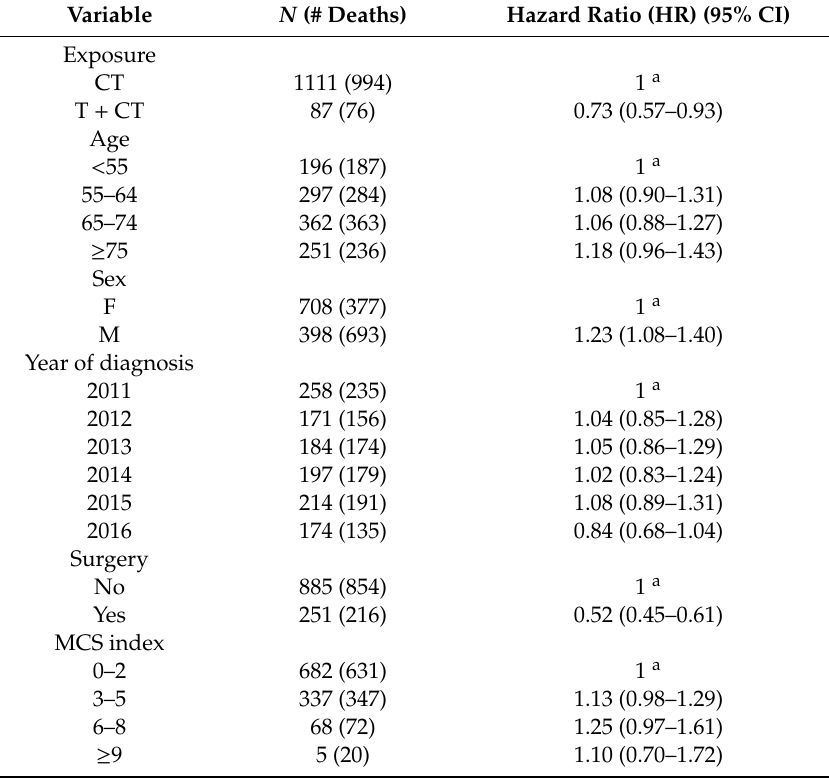
Table 2. Association between first-line treatment and overall survival in 87 metastatic gastric cancer patients treated with trastuzumab-based chemotherapy (T + CT) and 1111 patients treated with standard chemotherapy